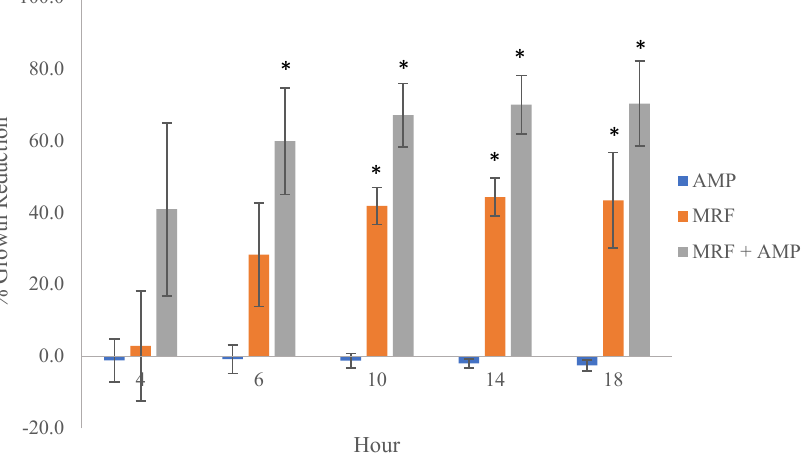
Figure 4. The effect of MRF and antibiotic treatment on the growth of antibiotic-resistant E. coli ( n = 3) relevant to control culture. AMP (0.5 µgmL − 1 AMP), MRF (5 mgmL − 1 ), or a combination of AMP (0.5 mgmL − 1 ) + MRF (5 mgmL − 1 ) cultures. Standard error is represented by error bars. Means that were significantly different to one another within each time point are marked with an asterisk (*), p ≤ 0.05, ANOVA.